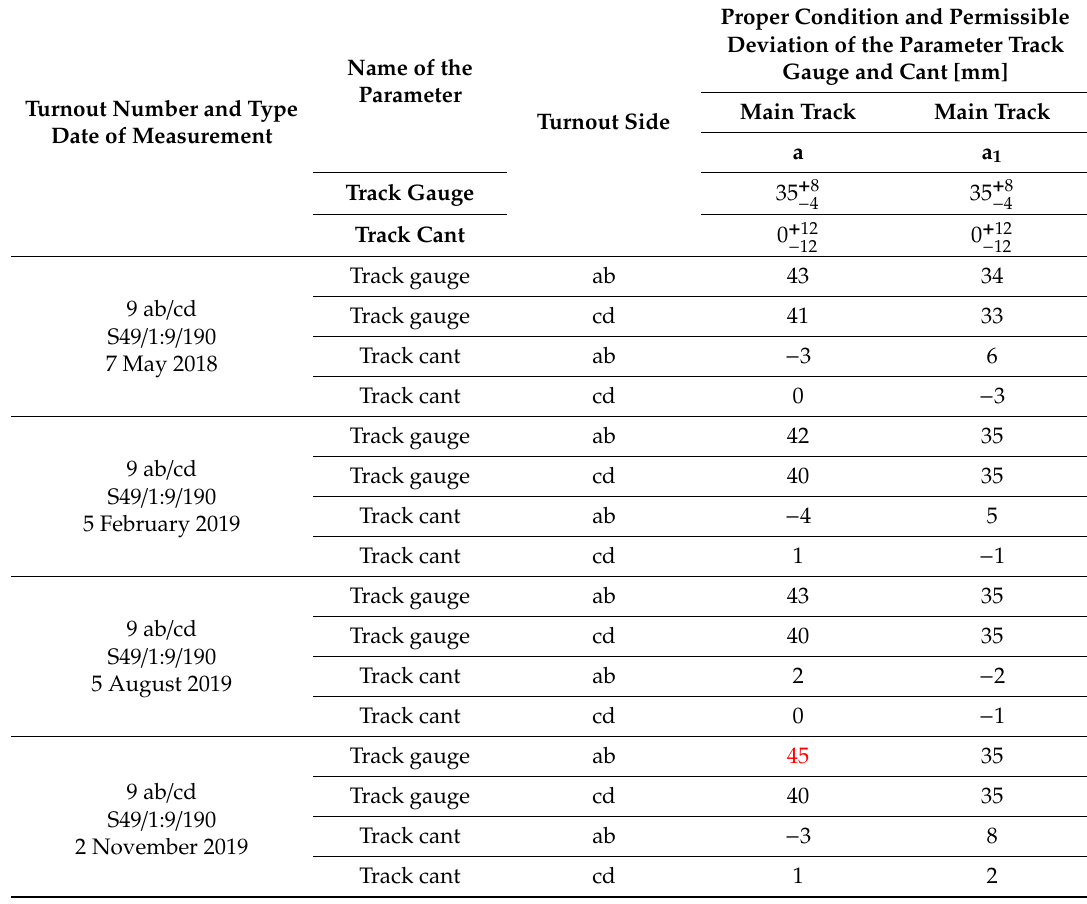
Table 2. Values of the parameter track gauge and cant for the turnout pre-blade contact at points a